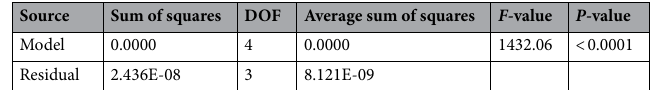
Table 10. ANOVA Analysis for the recovery factor in low permeability region.